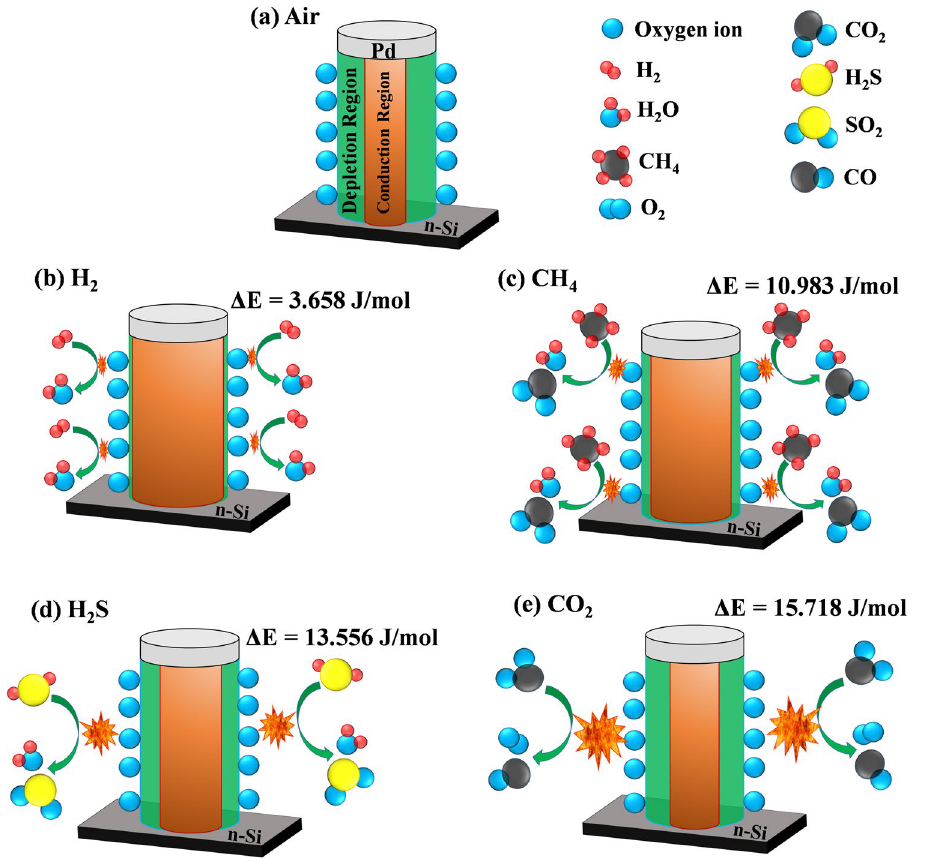
Figure 9. The gas sensing mechanism for sensor; a relative change in depletion region of ZnO NRs in presence of ( a ) Air, ( b ) H 2 , ( c ) CH 4 , ( d ) H 2 S and ( e ) CO 2